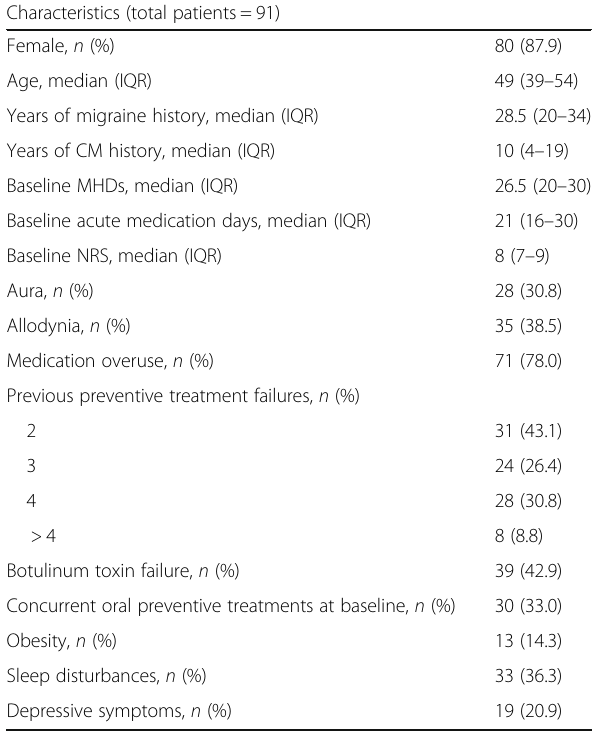
Table 1 Characteristics of the study patients Characteristics (total patients = 91)